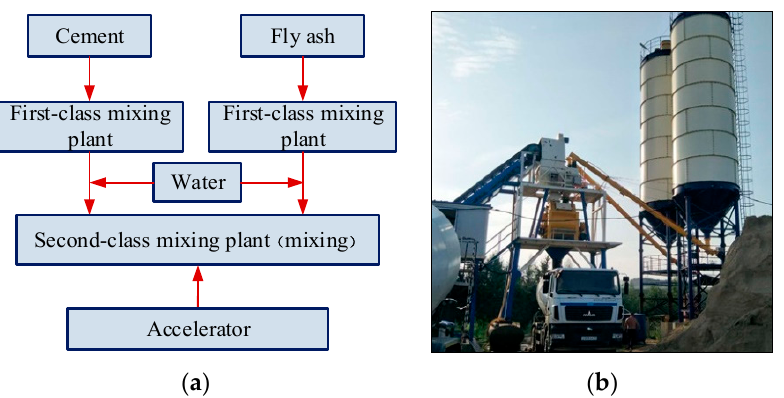
Figure 8. Schematic diagram of the slurry-making process and the mixing plant: ( a ) Slurry-making process flow diagram; ( b ) Mixing plant.